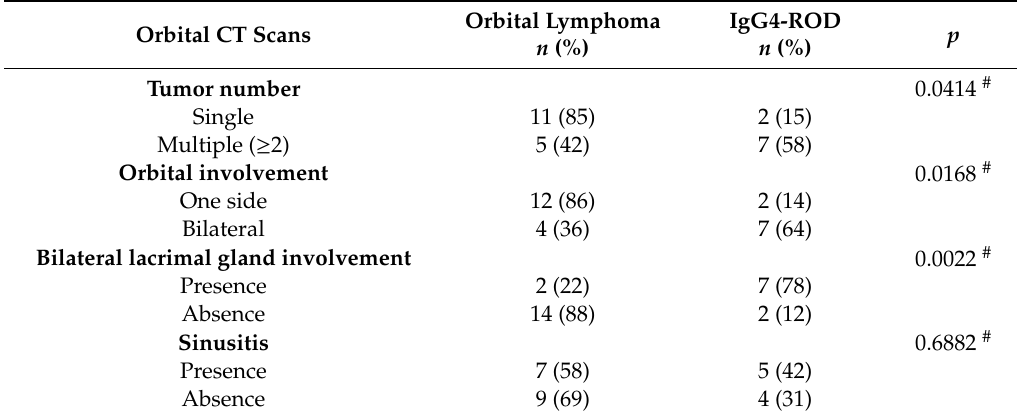
Table 2. CT features of the 25 patients with orbital lymphoma or immunoglobulin G4-related orbital disease (IgG4-ROD) on prebiopsy orbital CT